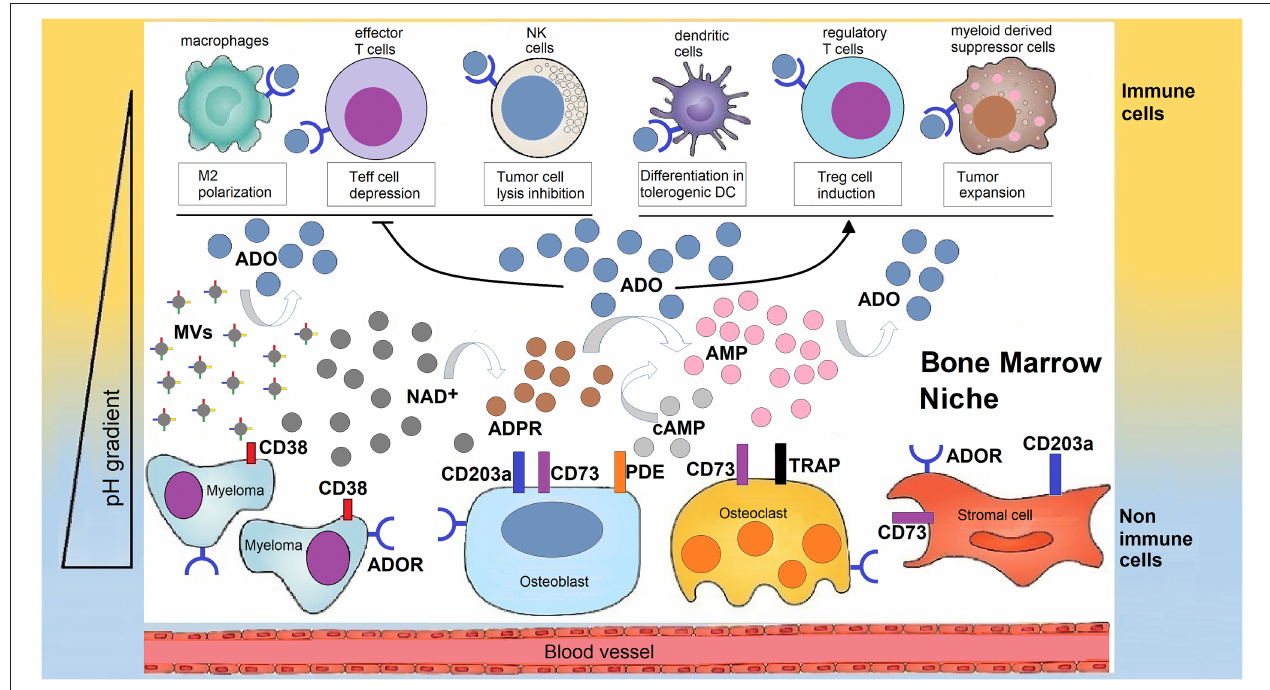
FIGURE 2 | Human bone marrow sheltering malignant plasma cells, bone cells, and immune cell, supports the production of adenosine for the generation of a tolerant niche. In a closed BM niche, ADO is mainly obtained from NAD + (and possibly from cAMP) which undergoes reaction through a multicellular chain of ectonucleotidases (CD38, CD203a, and CD73 or TRAP depending on pH status regulated by metabolic reprogramming). According to this view, NAD + is disassembled into byproducts that flow in the BM plasma fluid within the myeloma niche, accumulating variable amounts of ADO. Most of ADO is taken-up by purinergic cell receptors (ADOR) expressed by bone cells or immune cells inside the niche. The outcome is either a block of the effectiveness of immune cells (Teff, NK, TAMs) that are capable of destroying tumor cells or that increase the number of regulatory T-cells (Tregs), mesenchymal derived stromal cells (MDSC), or dendritic cells (DC) which suppress immune cells from responding to the